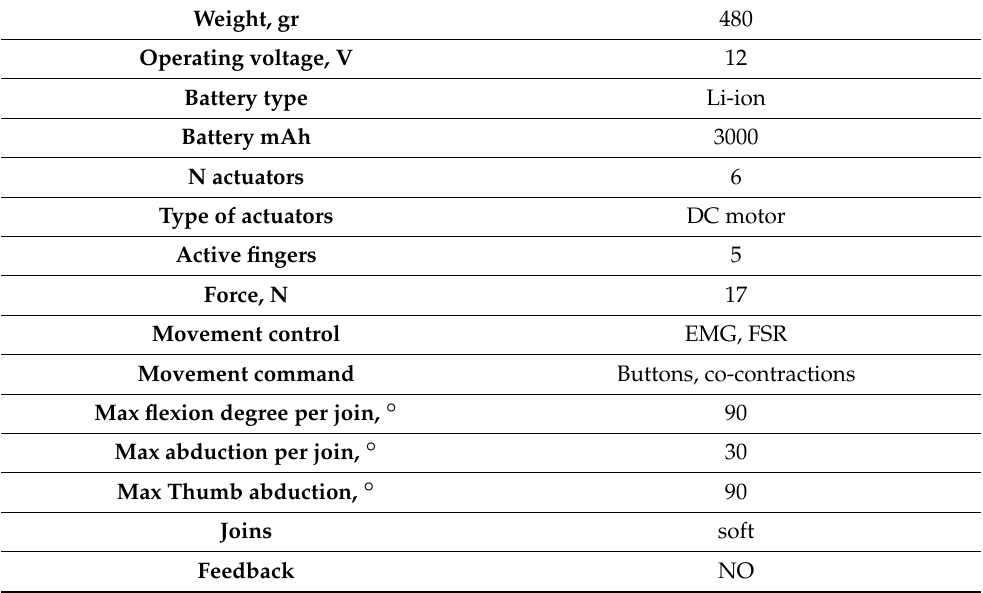
Table 4. Prosthetic hand